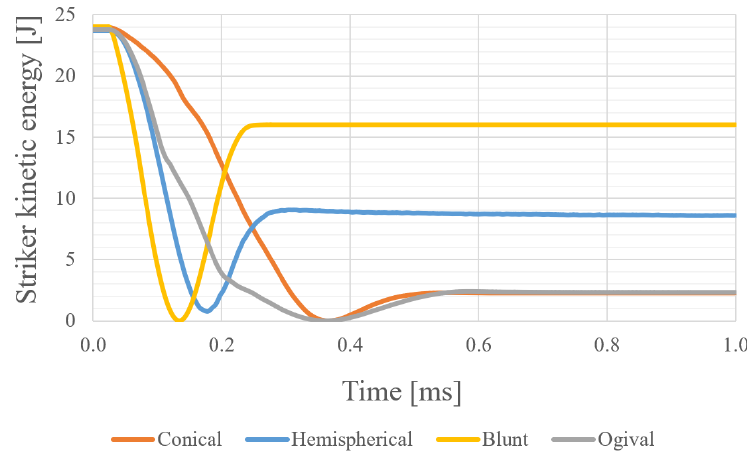
Figure 9. Kinetic energy of strikers during impact depending on their geometry.